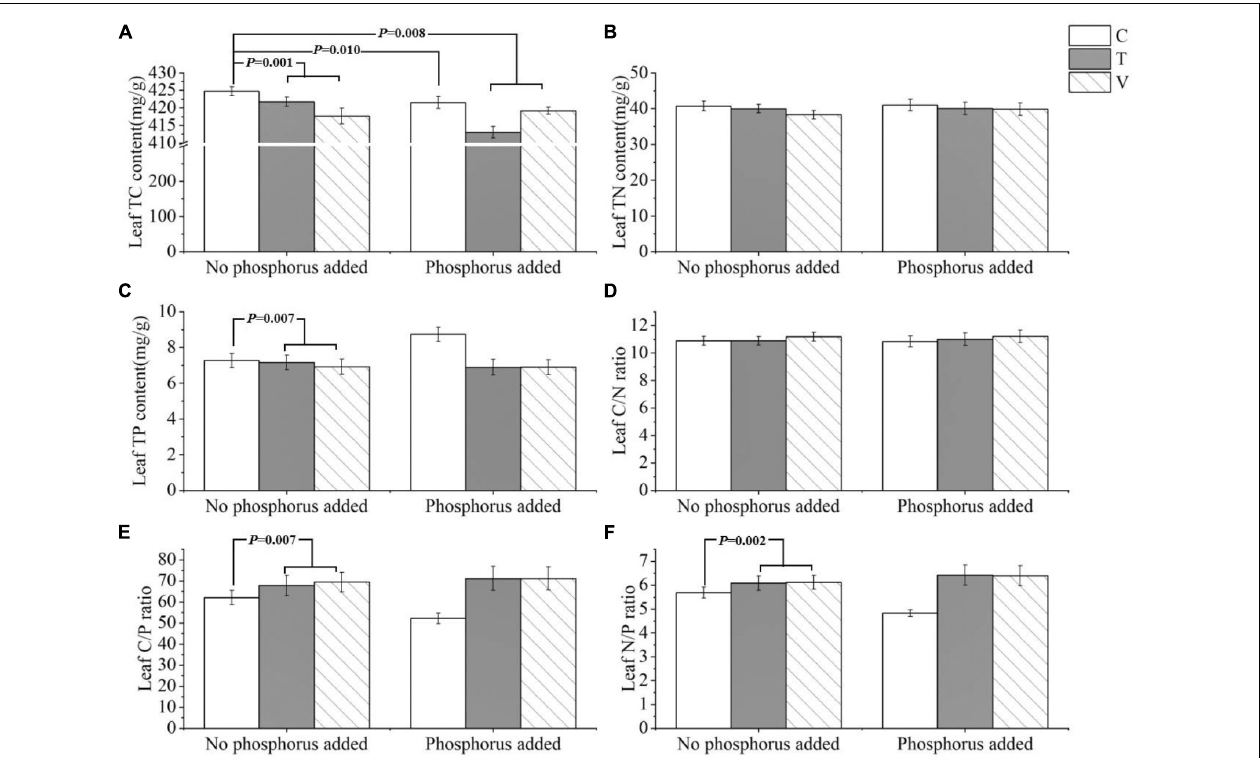
FIGURE 1 | The stoichiometric characteristics of the (A) TC, (B) TN, and (C) TP contents and the (D) C/N, (E) C/P, and (F) N/P ratios of P. crispus leaves under different treatments. The C in “No phosphorus added” represent controls (C), T in “No phosphorus added” represent constant warming (T), and V in “No phosphorus added” represent variable warming (V). Meanwhile, the C in “Phosphorus Added” represent phosphorus addition (C + P), T + P in “Phosphorus Added” represent constant warming and phosphorus addition (T + P), and V + P in “Phosphorus Added” represent variable warming and phosphorus addition (V +